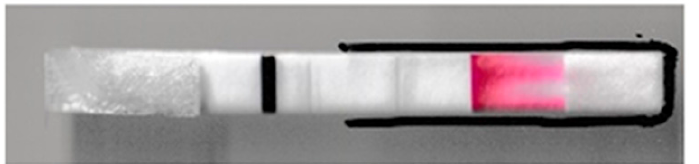
Figure 5. Lateral flow strip that was previously designed and tested. Color streaking and non- uniformity was observed in the detection zone